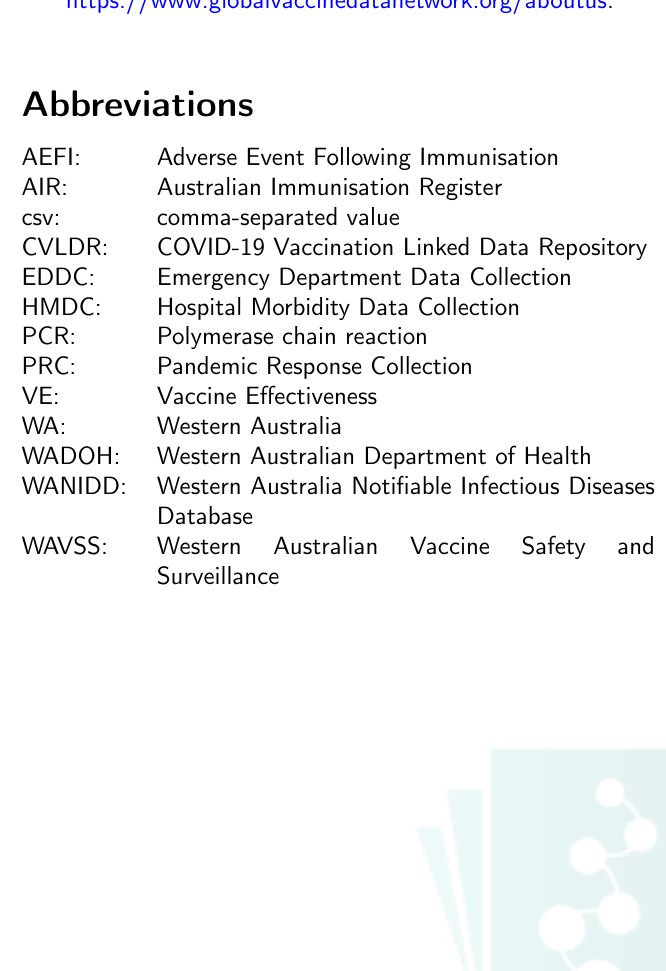
Data Network - About Us 2022 [Available